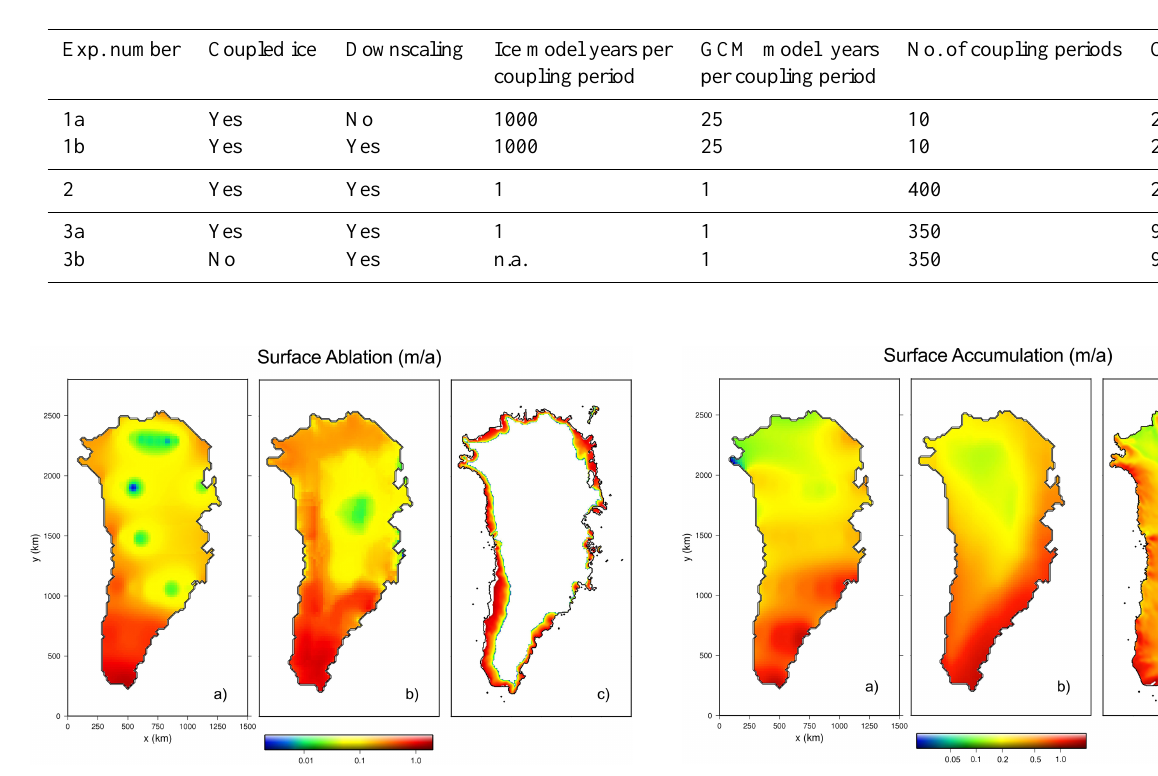
Table 2. Overview of experiments performed. All simulations started from the same initial data described in Sects. 2.1 and 4. Note that some do not include a coupled ice sheet; these were done for reference.